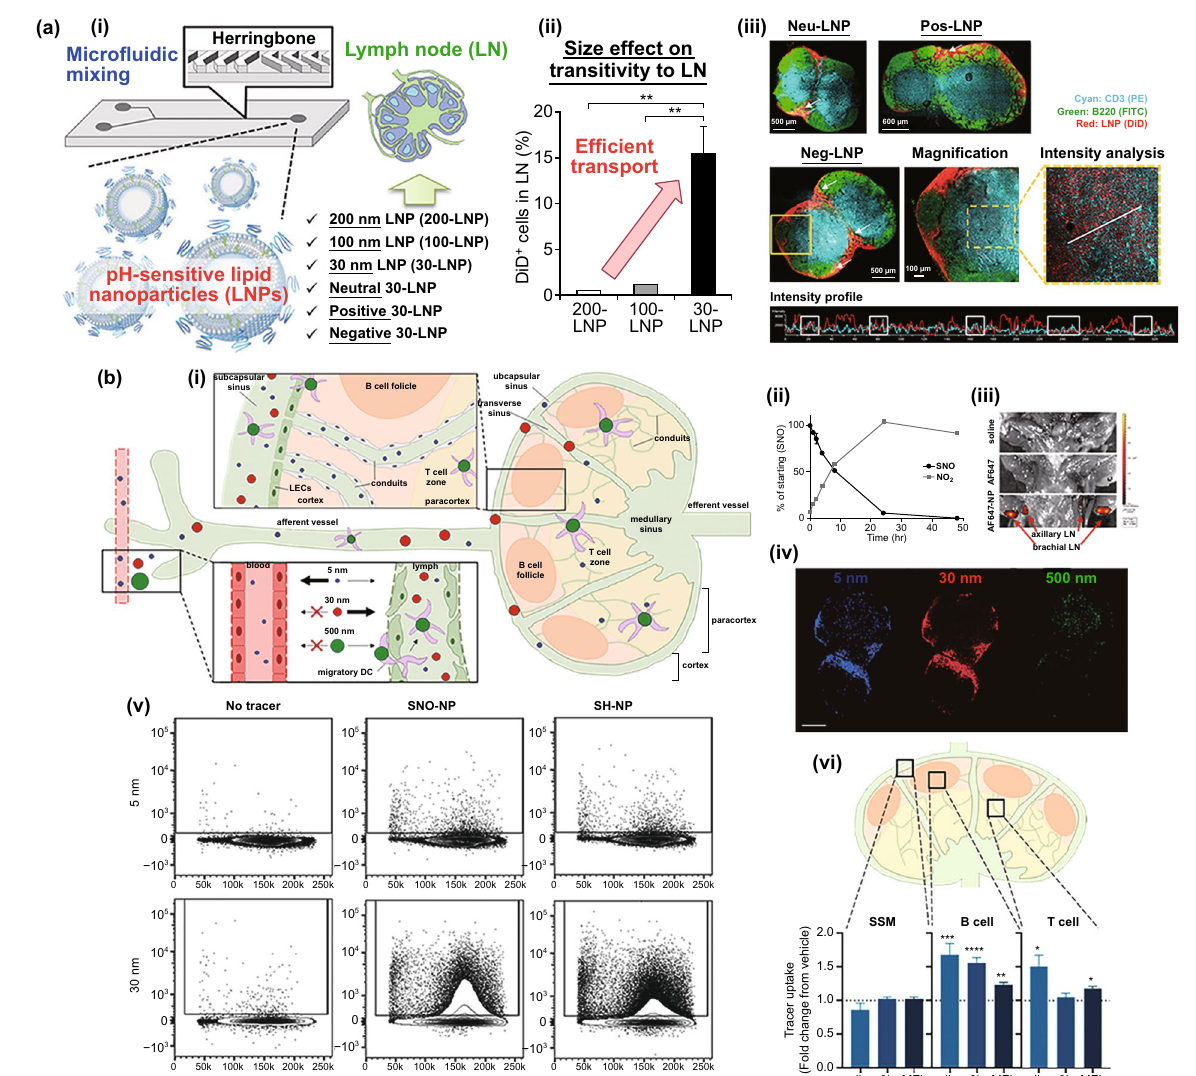
Fig. 5 a (i–ii) Scheme of effect of size and charge of lipid nanoparticles prepared by microfluidic mixing on their lymph node transitivity and distribution. (iii) CLSM images of LNs treated with each LNP. The white arrows represent yellow dots showing the colocalization of B220 + cells and LNPs. An intensity analysis was performed in the range of the white line. White squares in the intensity profile represent the colocali- zation of CD3 + cells and LNPs. Cyan, green, and red show CD3 (PE), B220 (FITC), and LNP (DiD), respectively. Reproduced with permission from Ref. [108]. b (i) Schematic of size-based effects on molecule drainage from the interstitium and into draining LNs (dLNs). Blue = 5 nm, red = 30 nm, and green = 500 nm molecules, (ii) S-nitrosothiol (SNO) and nitrite (NO 2 ) concentration in a solution of SNO-NP over time, (iii) IVIS imaging of AF647-labeled NP draining to axillary and brachial LN from a forelimb injection, (iv) confocal microscopy images of tracer distribution within a brachial LN 72 h after ipsilateral forelimb injection. Scale bar = 500 μm, (v) representative examples of CD45 + LN cells without 5 and 30 nm tracers, or with tracer and SNO-NP or SH-NP treatment, vi) effect of SNO-NP treatment on tracer uptake by barrier, cortex, and paracortex cell populations. Reproduced with permission from Ref.